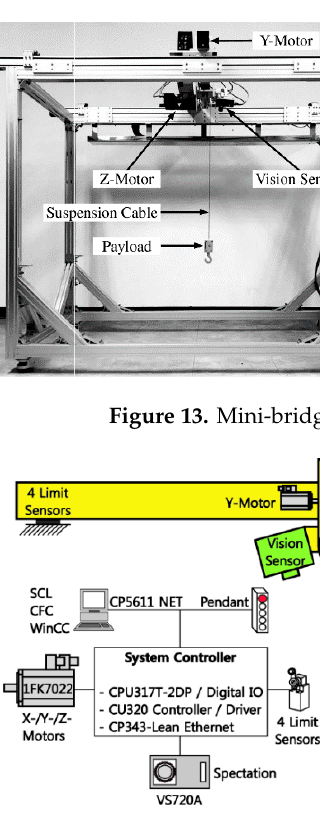
Figure 14. Hardware configuration.